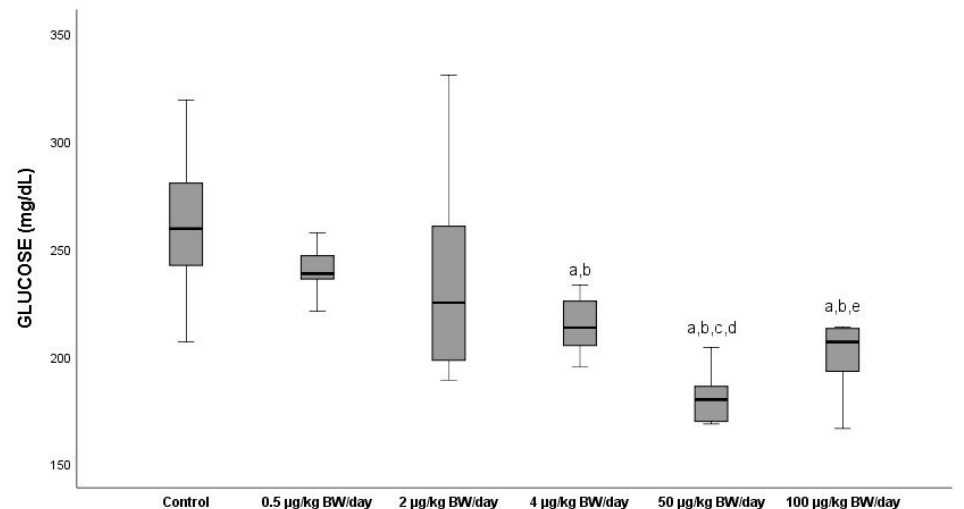
Figure 1. Means ± standard deviations of the serum levels of glucose (GLUC) expressed in mg/dL in the different exposure groups. a significant differences vs. control (G0) ( p < 0.05); b significant differences vs. 0.5 µg/kg BW/day (G1); c significant differences vs. 2 µg/kg BW/day (G2); d significant differences vs. 4 µg/kg BW/day (G3); e significant differences vs. 50 µg/kg BW/day (G4).